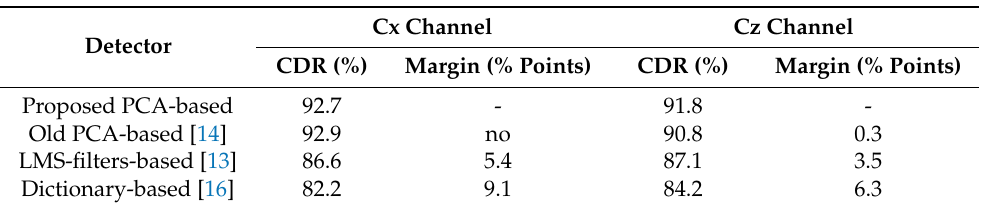
Table 2. CDR for different detectors using the 300 dpi scanned testing images, and statistically significant improvement of the proposed PCA-based detector.